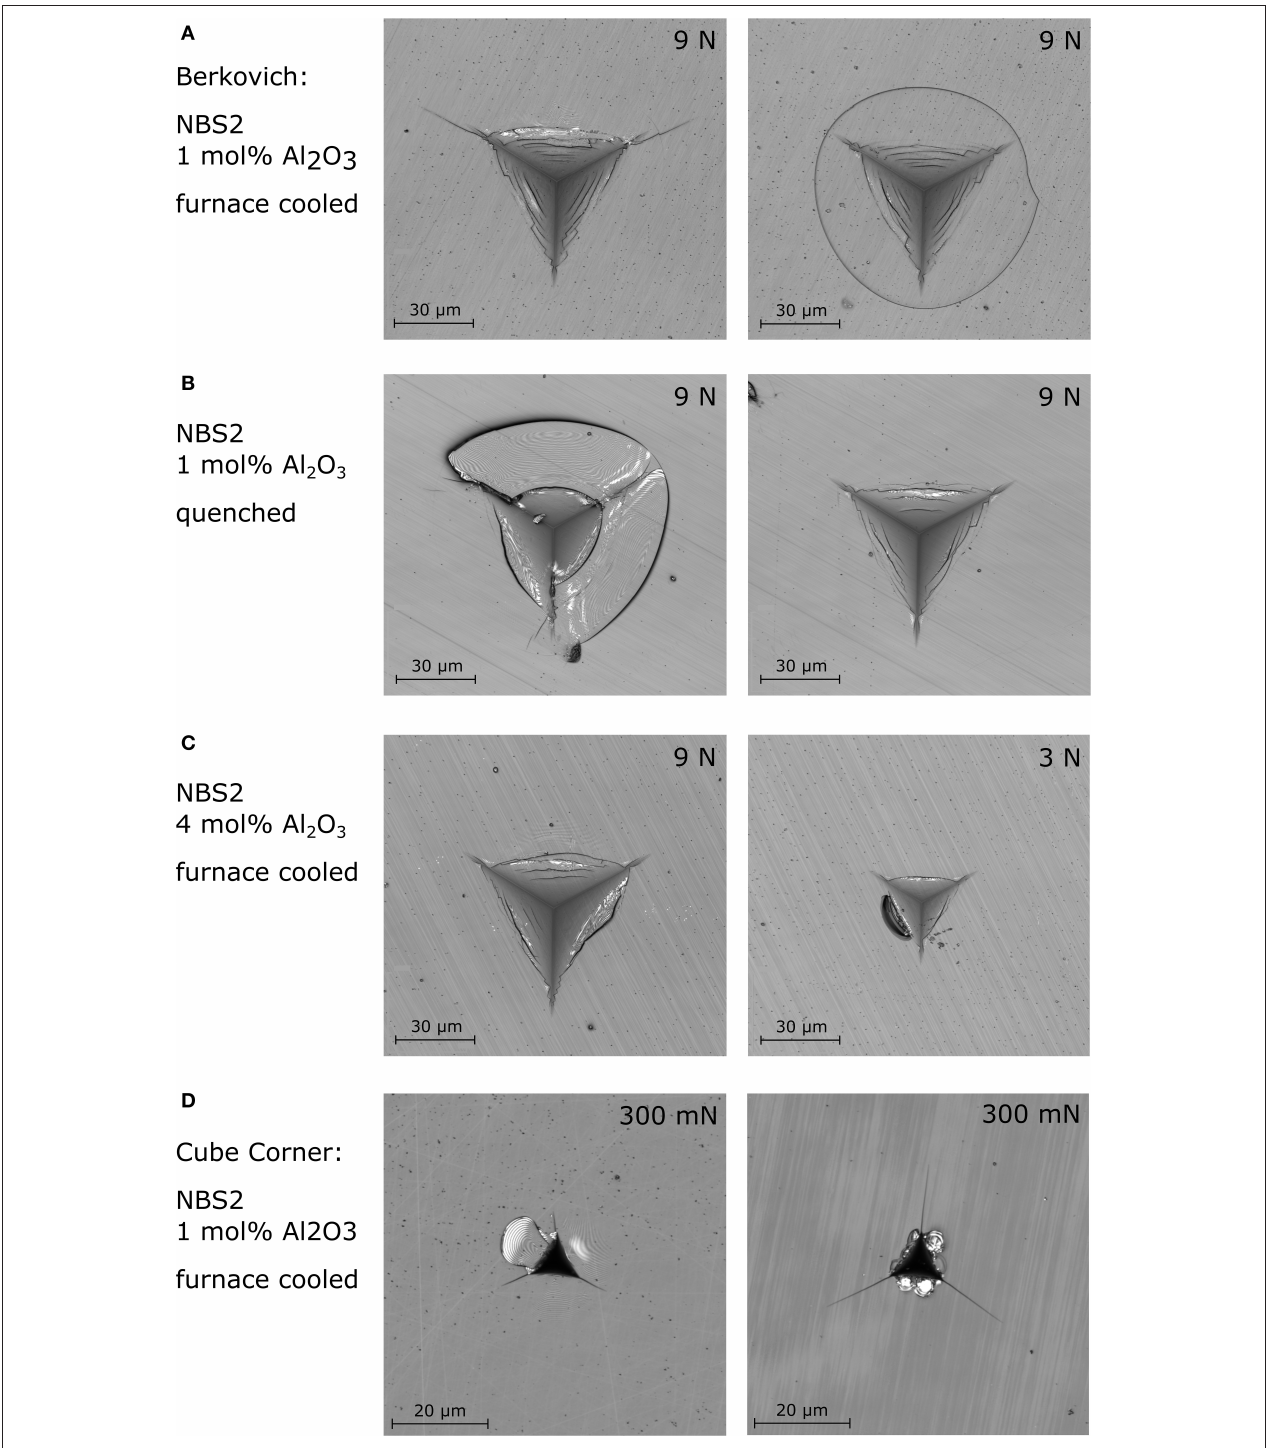
FIGURE 6 | Indentation cracking upon Berkovich indentation in (A) furnace cooled and (B) quenched NBS2 glass containing 1 mol% Al 2 O 3 as well as (C) in furnace cooled NBS2 with a larger Al 2 O 3 content of 4 mol%. (D) Cube corner indentation cracking in conventional furnace cooled NBS2 glass. Even though the loading is equal in both cases, the radial crack length scatters from 11.8 ± 0.8 µ m (left) to 21.4 ± 0.4 µ m (right), depending on the extent of chipping.